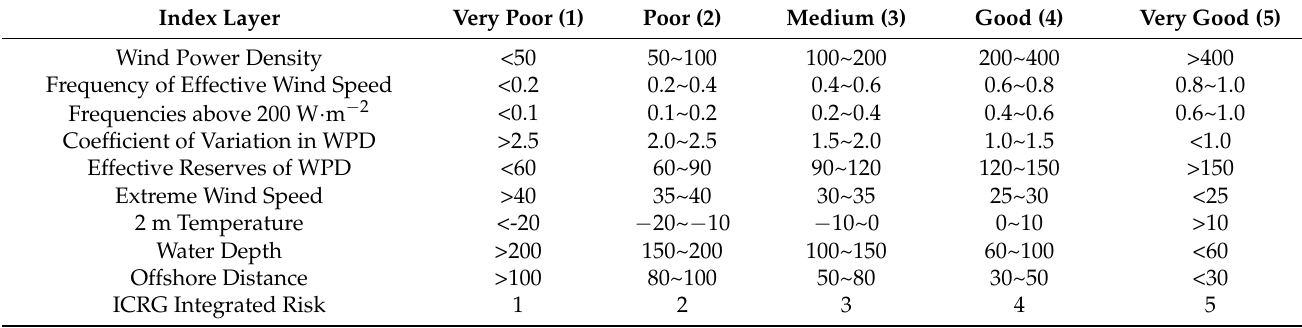
Table 3. Index grade